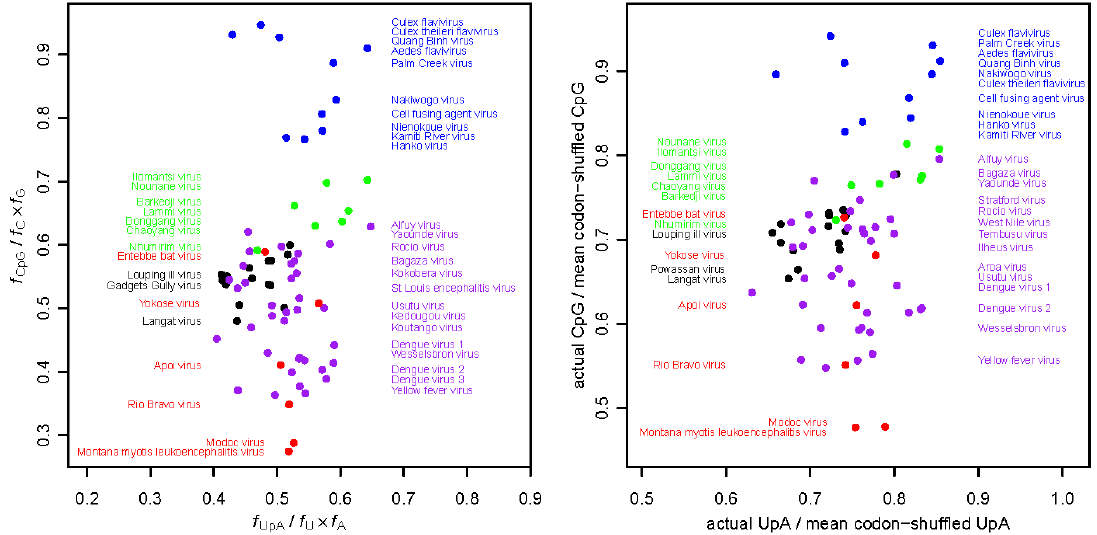
Figure 5. Relative UpA and CpG frequencies in different flavivirus species. UpA and CpG frequencies were calculated in two different ways. ( A ) In each sequence, the numbers of UpA and CpG dinucleotides, and A, C, G and U mononucleotides, were counted. Dinucleotide frequencies, f XpY , were expressed relative to their expected frequencies, f X x f Y , in the absence of selection; ( B ) Since codon usage reflects dinucleotide bias but can also be subject to other selective pressures (e.g., for translational speed or accuracy) that, due to co-evolution of dinucleotide and codon preferences in the host, may lead to the same dinucleotide biases, we also calculated dinucleotide biases independent of codon (and amino acid) usage. To factor out codon and amino acid usage, 1000 shuffled ORF sequences were generated for each virus sequence. In each shuffled sequence, the original amino acid sequence and the original total numbers of each of the 61 codons were maintained, but synonymous codons were randomly shuffled between the different sites where the corresponding amino acid is used in the original sequence. Then the UpA and CpG frequencies in the original sequence were expressed relative to their mean frequencies in the codon-shuffled sequences. Because codon usage is factored out, the UpA and CpG relative frequencies tend to be less extreme in ( B ) compared to ( A ). Since many sequences lack complete UTRs, for consistency, both analyses of all species were restricted to the polyprotein ORF. Each point represents a single flavivirus sequence. Points and selected species names are color-coded as follows: cISFs—blue; dISFs— green; NKV flaviviruses—red; mosquito/vertebrate flaviviruses—purple; tick/vertebrate flaviviruses—black. GenBank accession numbers are the same as those used in Figure